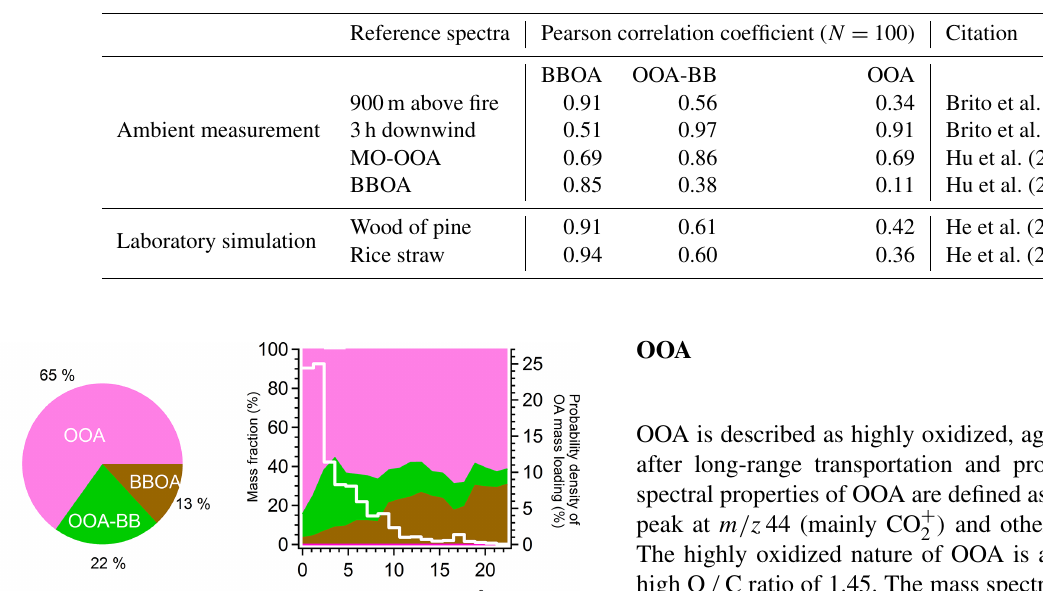
Figure 5. The time series of three OA factors resolved by PMF, together with acetonitrile. The gray background areas denote the biomass burning events (identified in Sect. 4.1). Table 1. A comparison between the mass spectra of different OA with reference spectra.